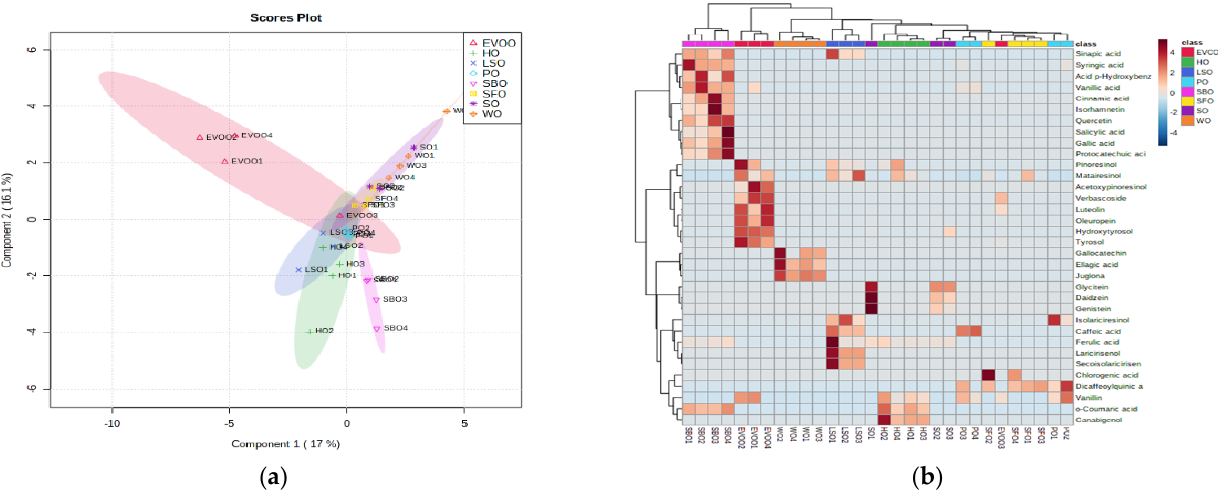
Figure 5. ( a ) PLSDA score plot for the discriminatory analysis of the eight categories of oils, consid- ering their content in phenolic derivatives. ( b ) Heatmap representing the Euclidian distance, and by the Ward algorithm, the similarities between individual oil samples inside a group and among groups.